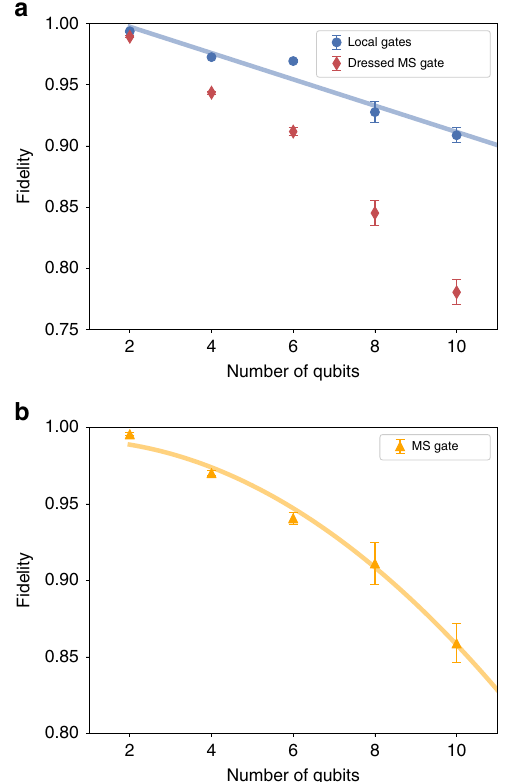
Fig. 3 Experimental estimates of how rapidly error rates increase as the processor size increases. a Process fi delities obtained under cycle benchmarking for local gates (blue circles) and for sequences containing dressed Mølmer – Sørensen (MS) gates (red diamonds), that is, MS gates composed with a random Pauli cycle, plotted against the number of qubits in the register. The local operations are consistent with independent errors fi tted according to Eq. (8). b Estimate of the process fi delity of an MS gate obtained by taking the ratio of dressed MS and local process fi delities. The data are fi tted to Eq. (9) and is consistent with a constant error per two- qubit coupling.